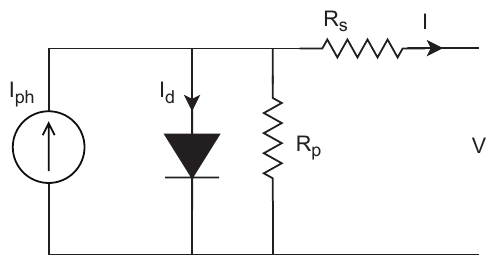
Figure 1. The model of a photovoltaic (PV) cell: one diode